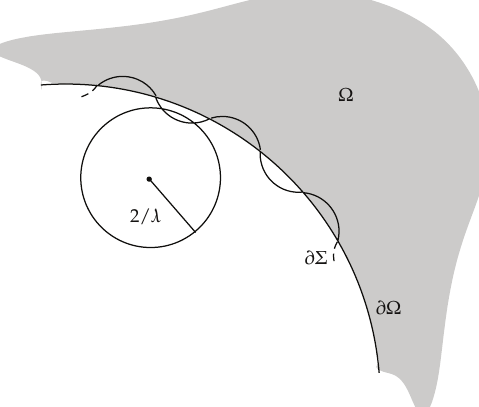
Figure 1: Example of the boundary of a possible minimizer Σ that does not meet Ω tangentially and illustration of a ball of radius 2 /λ ⊂ Ω c that can be used to find a new minimizer, as described in (cid:2) 3 (cid:3) .